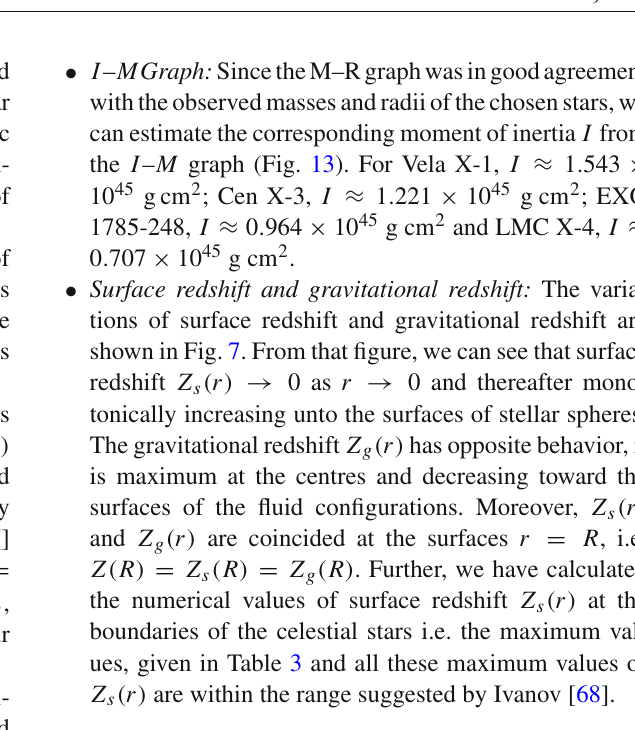
Table 3 Estimated values of the central and surface densities, cental pressure, surface redshift at the boundary and twice of compactness parameter with buchdahl limit for four celestial compact stars corresponding to the values of constants given in Table 2